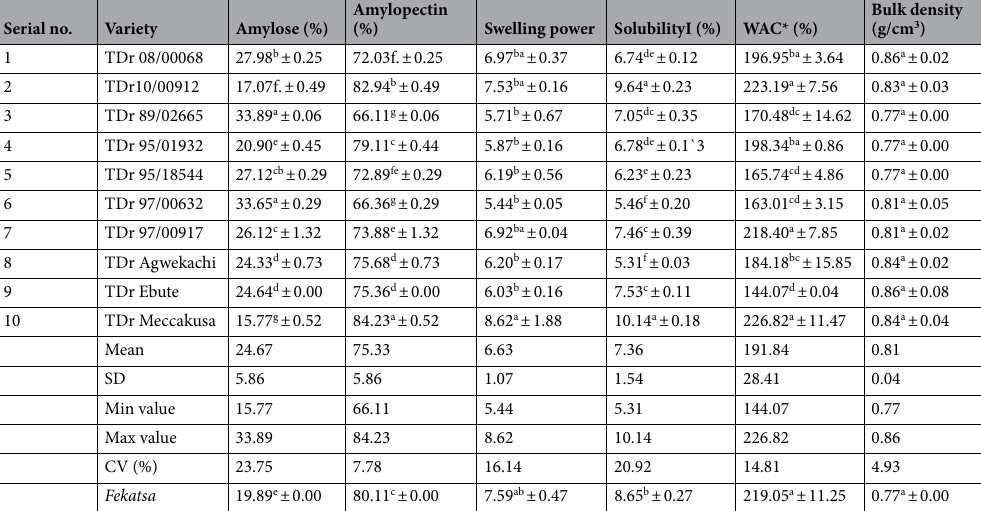
Table 1. Yam varietal effects on flour physicochemical characteristics as obtained from Dioscorea rotundata control and improved 10 varieties. * WAC Water absorption capacity; Solubility I: Solubility Index. a Parameter mean value ± SD; Means with the same superscripts in the same column are not significantly different ( p >